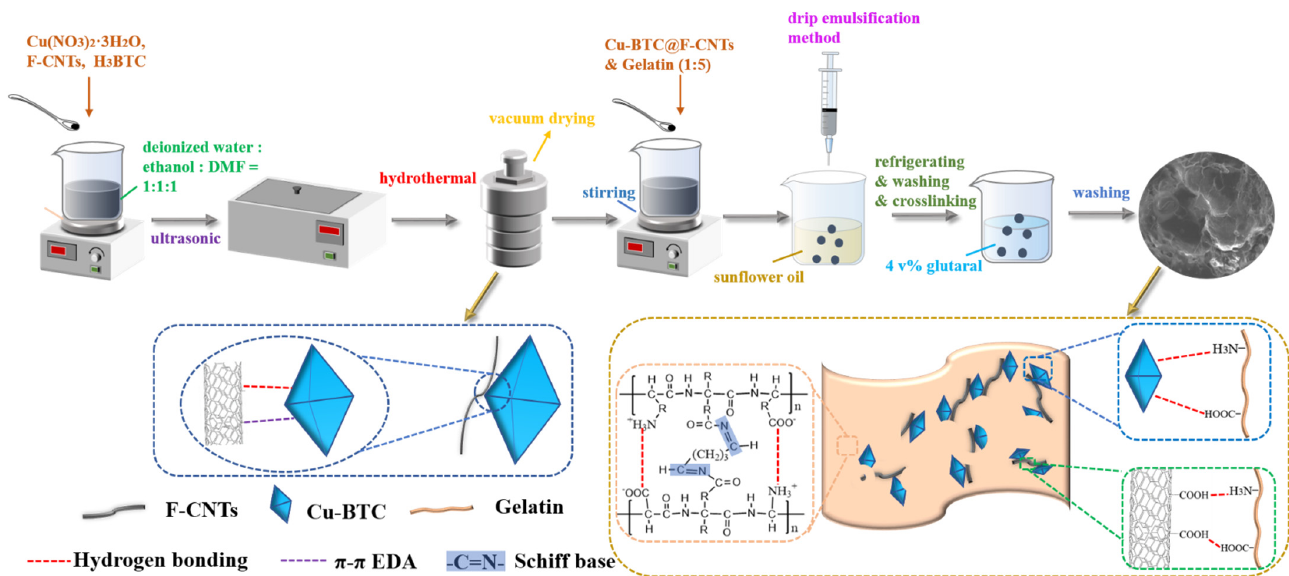
Figure 1. The preparation process of composite